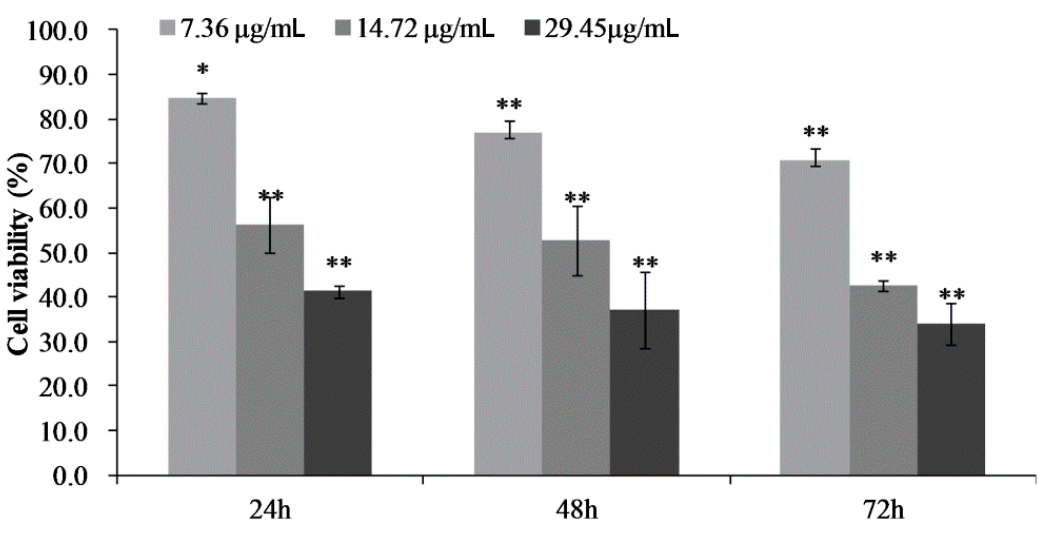
Figure 3. Effects of the CPhG liposome on the activation of HSCs. The cell viability of HSCs after 24, 48, and 72 h of exposure to the CPhG liposome determined by the MTT. Data are presented as the mean ± SD ( n = 4). * p < 0.05 and ** p < 0.01 compared with the control groups. Table 3. Influence of CPhGs liposomes on LDH secretion in HSCs.